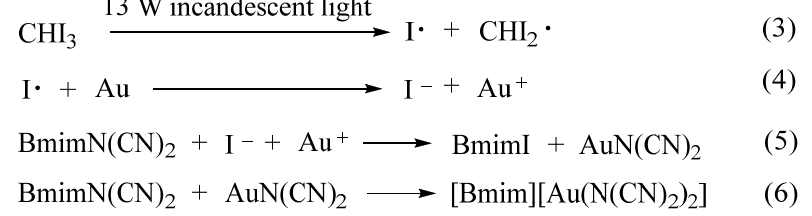
Scheme 2. Mechanism of dissolution of gold by CHI 3 /BmimN(CN) 2 .